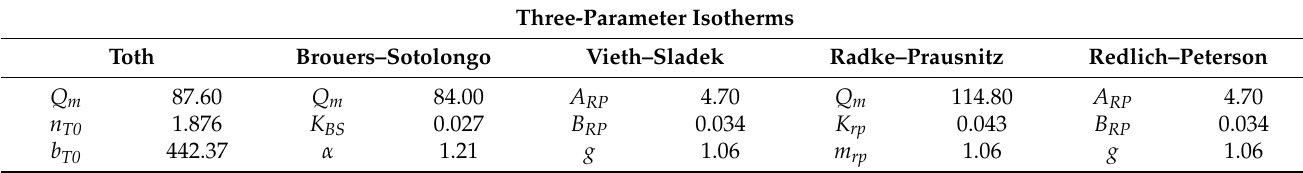
Table 3. Three-parameter isotherms.